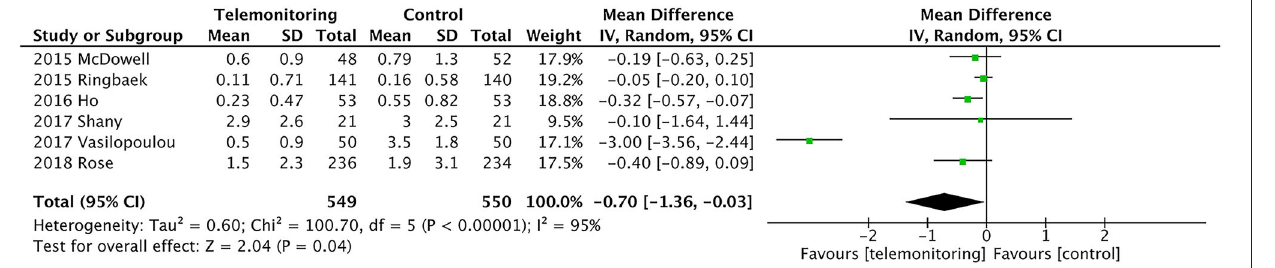
FIGURE 3 | A meta-analysis of ER visits. Df, degrees of freedom; M-H, Mantel–Haenszel.